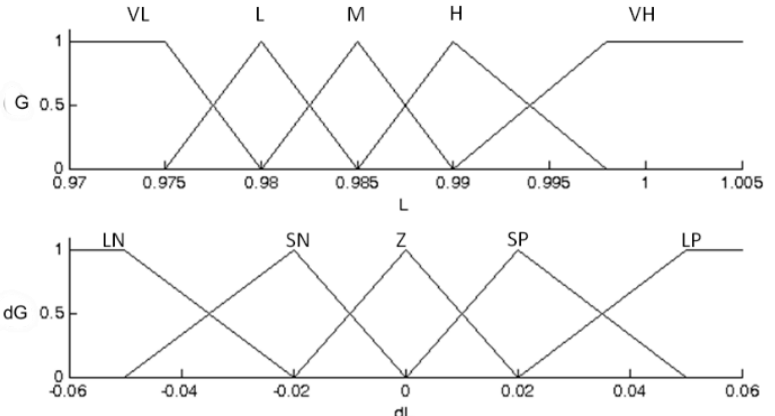
Figure 5. Fuzzy sets